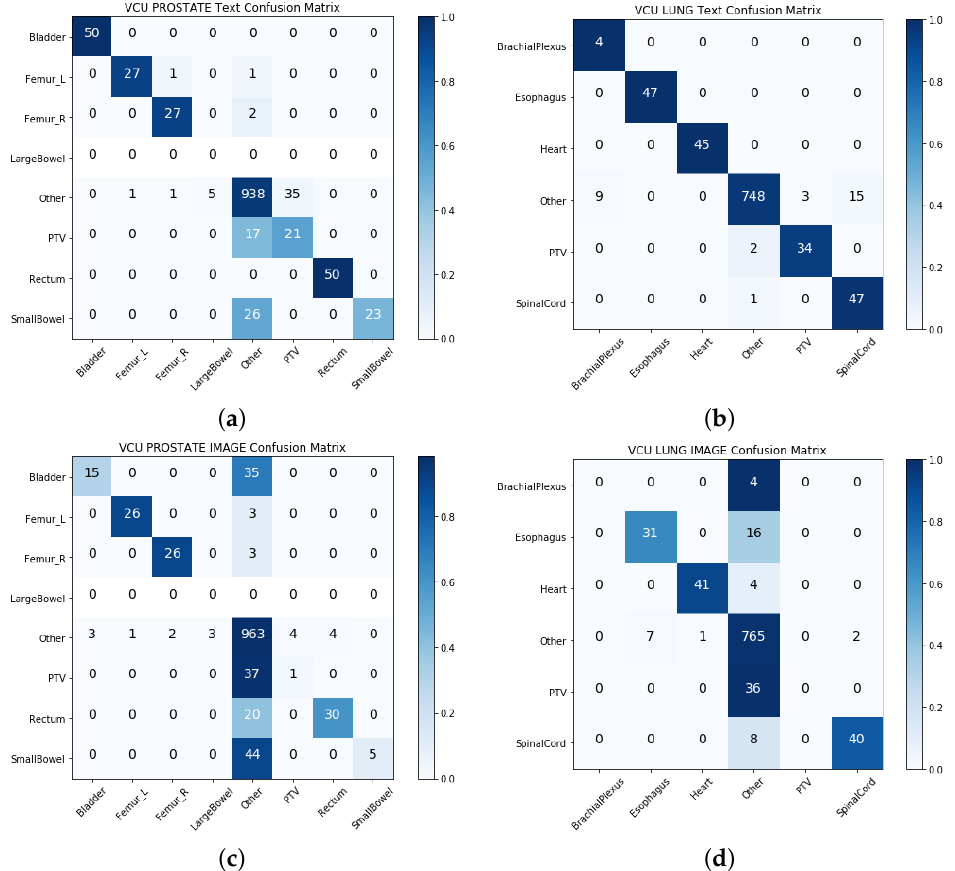
Figure 4. Single-view results: ( a ) VCU prostate text-based features. ( b ) VA-ROQS lung text-based features. ( c ) VCU prostate image features. ( d ) VCU lung image features. A darker color demonstrates more accurate prediction, and the diagonal shows the labels predicted